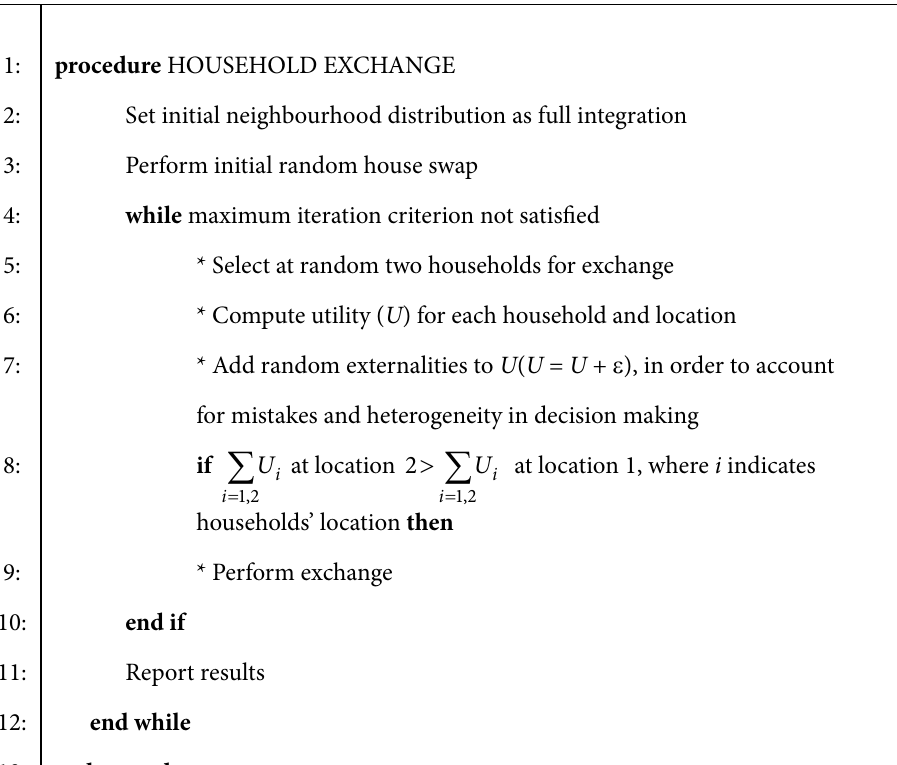
Algorithm 1 Household exchange algorithm